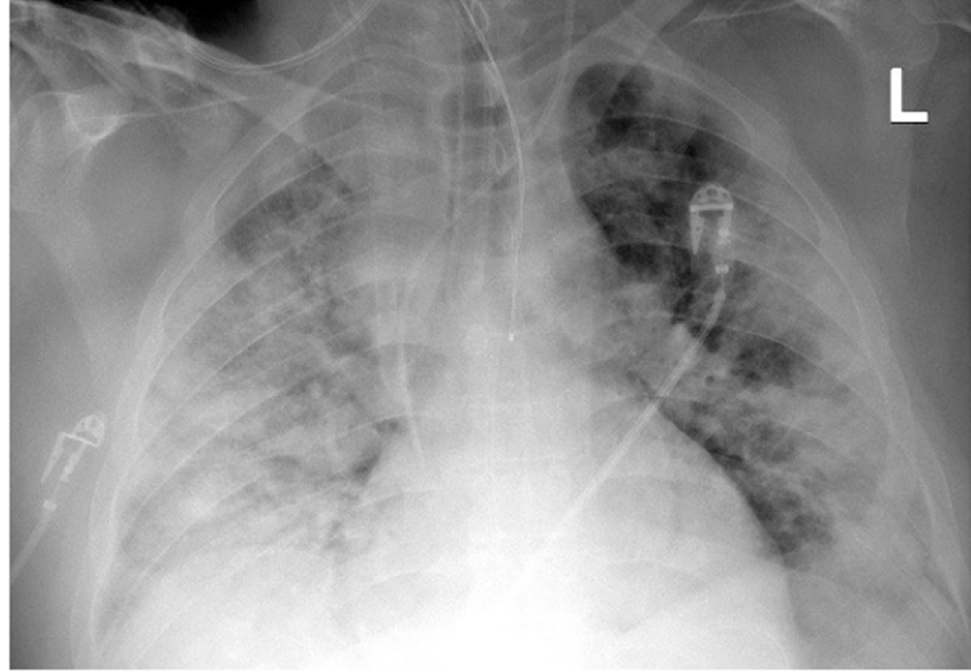
Figure 2. Chest X-ray after insertion of the 21F cannula into the superior vena cava (Case 1). A Medtronic Bio-Console 560 with a Medtronic Bio-Pump 540T and a Eurosets EU5520 oxygenator were used. Extracorporeal oxygenation was initiated, with a pump minute output of 6.5 L/min, RPM of 4540, and a 100% O 2 sweep gas flow of 8 L/min . The procedure was performed using anticoagulation therapy with unfractionated heparin by intravenous infusion under the control of activated clotting time (ACT) in the range of 200–230 s. After ECMO was initiated, lung-protective mechanical ventilation was conducted in the SIMV (PC)+ VS mode, PEEP 10–15 cmH 2 O, Pplat ≤ 25 cmH 2 O, respiratory rate (f)-6/min, driving pressure ( ∆ P) < 15 cmH 2 O, FiO 2 < 0.5, and tidal volume (VT) ≤ 6mL/kg predicted body weight (PBW). PaO 2 was 72 mmHg and PaCO 2 37 mmHg. Initially, it was not possible to obtain satisfactory values of capillary blood saturation, despite the use of optimal pump operation parameters. The position of the cannulas was checked with an ultrasound examination. The intake cannula was found to be too high, and it was withdrawn, positioning it approximately 5 cm below the entrance of the inferior vena cava to the right atrium. Due to the abnormal values of the pressures in the ECMO system, gradual anemization of the patient, and the appearance of hemolysis markers (increased levels of bilirubin and myoglobin in the blood), oxygenator clotting was suspected. For this reason, the ECMO system was replaced, resulting in an improvement in oxygenation and withdrawal of the above-mentioned symptoms. During the ECMO therapy, the patient periodically required stabilization of the arterial pressure infusion of noradrenaline. The initial measure of C dyn was 25 mL/cm H 2 O with a